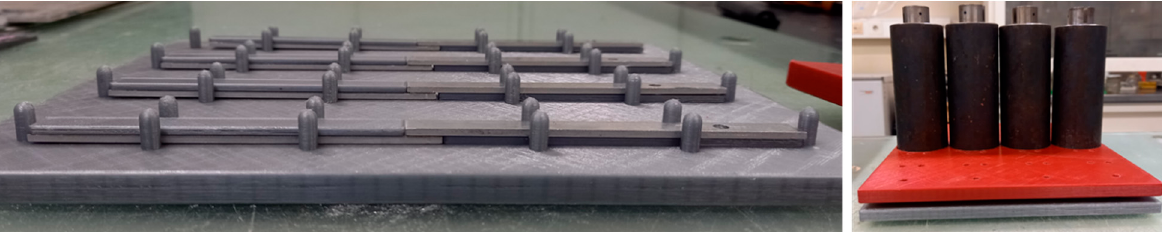
Figure 3. Joints after assembly ( left ) and the final result with the weights placed ( right ).